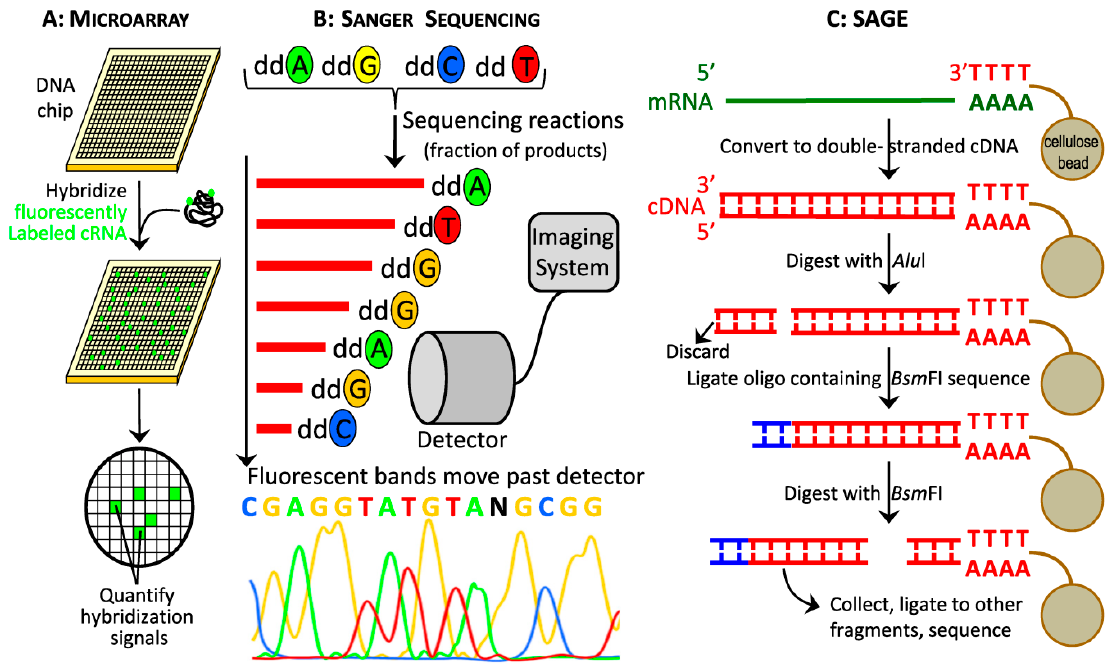
Figure 3. Older technologies used in gene expression studies. ( A ) In microarray experiments, labeled